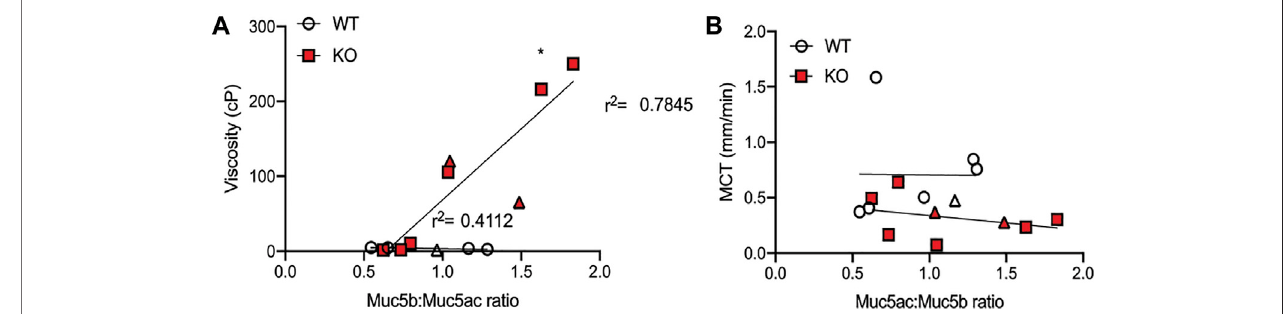
FIGURE 4 | Viscosity is dependent on Muc5b:Muc5ac ratio. Ratios were performed by calculating the proportion of Muc5b and Muc5ac on the data presented in earlier fi gures. (A) Data were compared to viscosity measurements conducted previously on mucus samples from baseline samples and samples collected under methacholine stimulation (in triangle shape). Linear regression was calculated for the measurements from WT and KO separately. KO points generated a line that was signi fi cantly non-zero and had an r 2 of 0.785, while WT points generated a line that was not signi fi cantly different than zero and had an r 2 of 0.4112. (B) Muc5b: Muc5ac ratios werealso comparedtomucociliary transport ratesmeasured in WT and KO ratsat baselineand under methacholinestimulation. Thesepoints generated lines that were not signi fi cantly different than zero in either genotype.